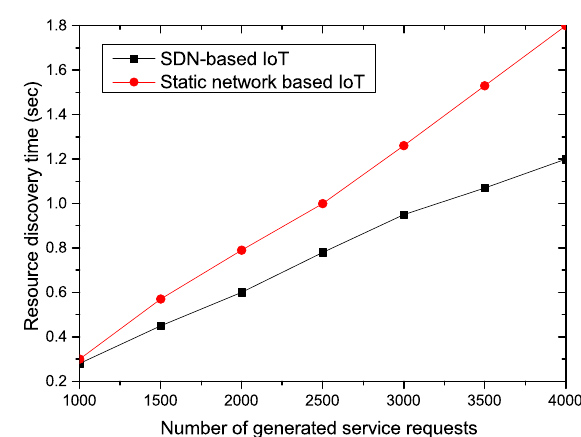
Figure 2. Resource discovery time vs number of service requests